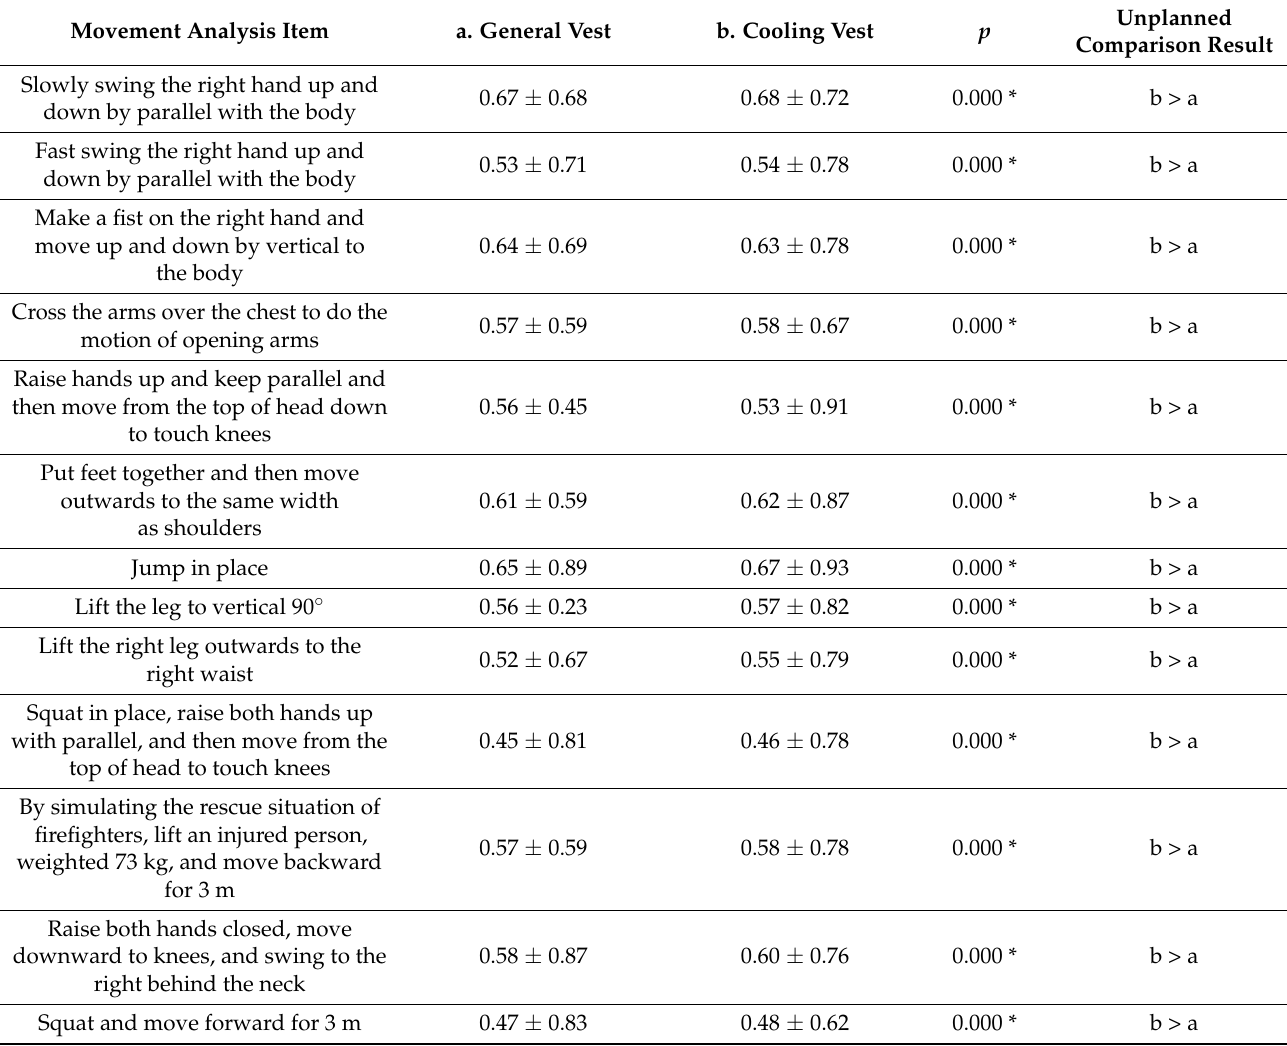
Table 5. Analysis of motion during tasks (Likert-type scale; mean ± standard deviation; and unit: %). Movement Analysis